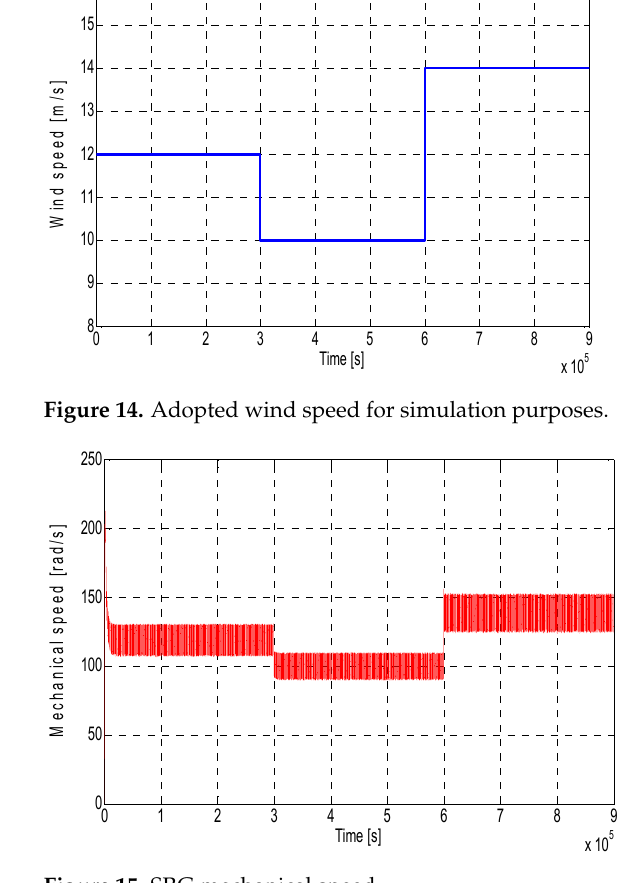
Figure 15. SRG mechanical speed.